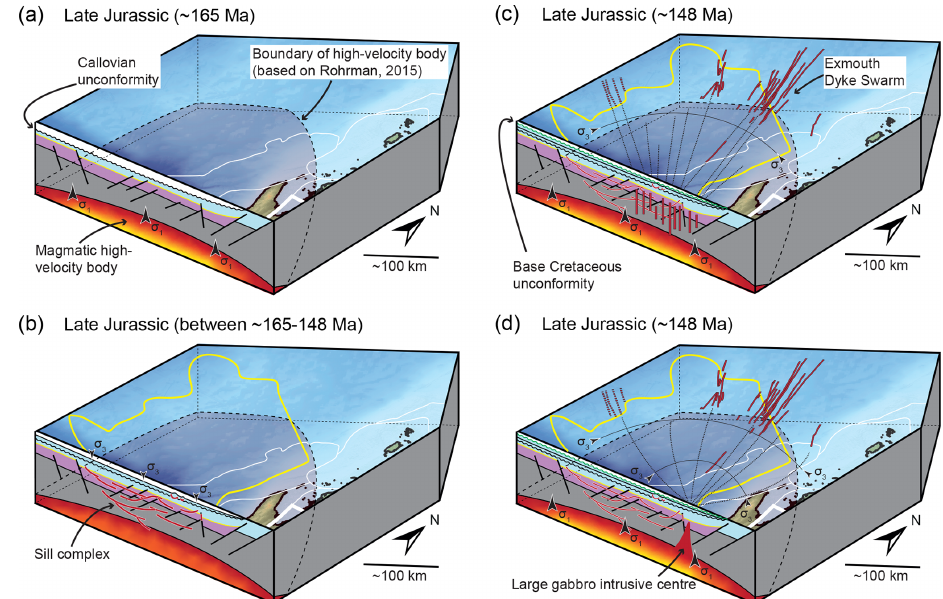
Figure 18. Schematics depicting the magmatic evolution of the study area during the Late Jurassic. (a) Initial igneous activity led to de- velopment of a high-velocity body at the base of the crust and synchronous uplift (i.e. horizontal σ 3 ) and erosion to form the Callovian unconformity. (b) As emplacement of the high-velocity body waned, uplift transitioned to subsidence, marked by a rotation to a vertical σ 3 and intrusion of sill complexes. (c–d) A renewed phase of magmatism and uplift rotated σ 3 to a horizontal orientation that favoured formation of the Exmouth Dyke Swarm. The Exmouth dyke swarm may have been fed directly from a mantle plume (c) or a large volcanic centre (d)